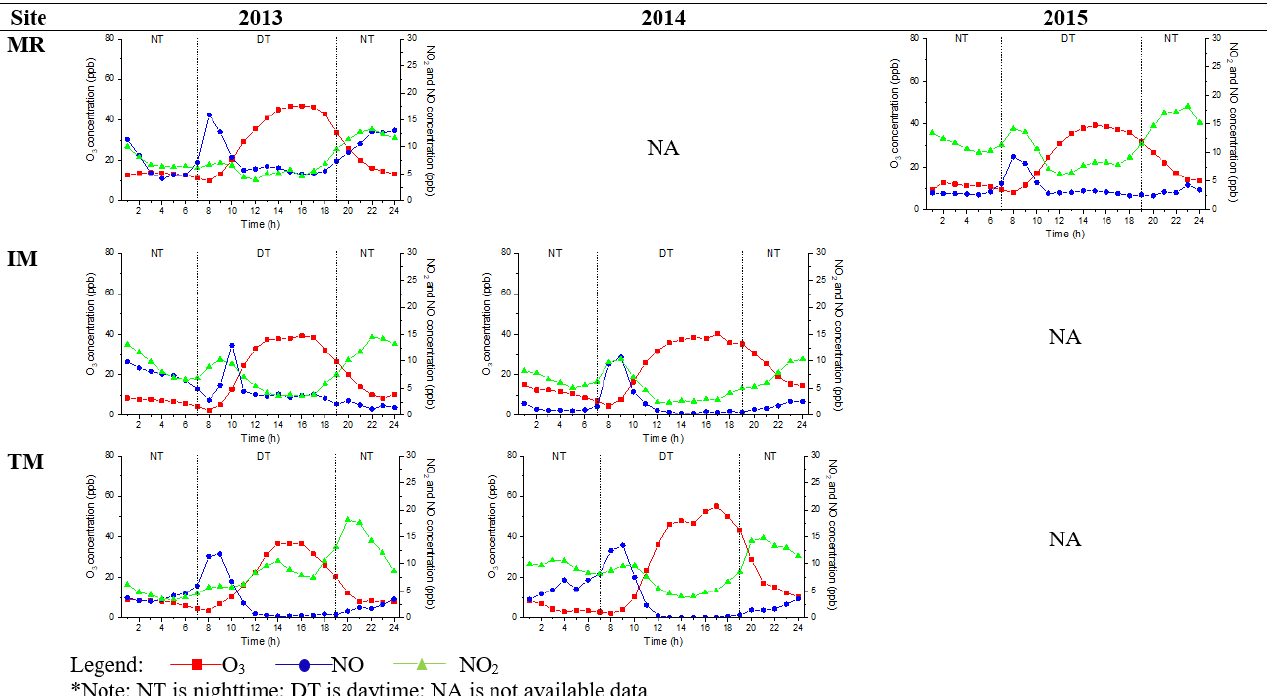
Figure 3. Hourly diurnal plots of O 3 , NO 2, and NO, at urban sites (PT, SB, and BM) in 2013, 2014, and 2015.